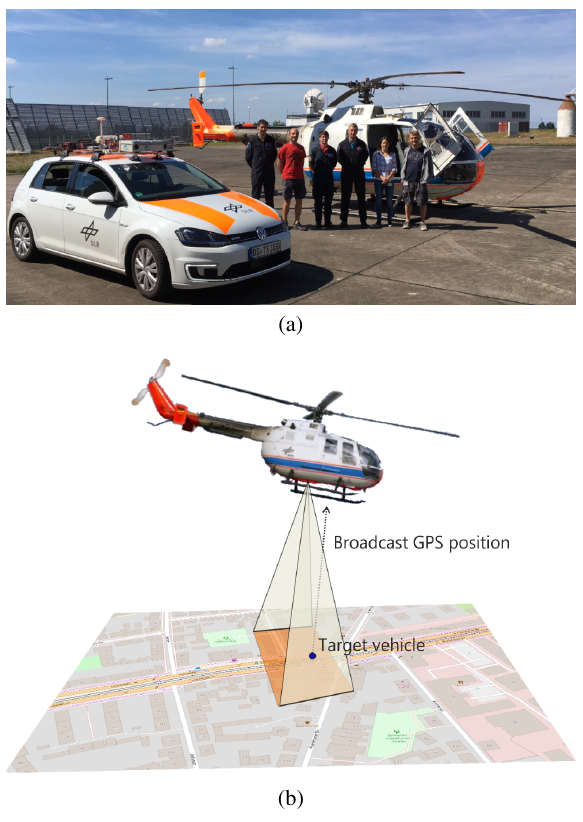
Figure 3. FASCarE and BO105 helicopter; (a) team during campaign days from 18 th till 20 th July 2017, (b) flight